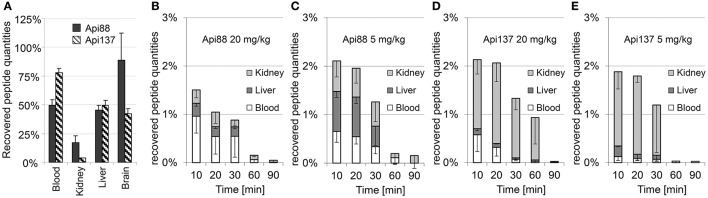
Mean recovery rates (n = 3) of Api88 and Api137 spiked to heparin blood or organ homogenates (A) and mean percentage rates recovered in blood, liver, and kidneys of mice treated intraperitoneal with doses of 20 mg/kg (B) and 5 mg/kg of Api88 (C) or 20 mg/kg (D) and 5 mg/kg of Api137 (E). Peptide distributions were calculated for plasma (one third of the whole mouse blood volume assumed to be 2.25 mL) and organs assuming that the peptides are present only in plasma and equally distributed in organ homogenates. Absolute quantities were calculated by assuming a total plasma volume of 25 mL/kg mouse weight and that organ volume in mL corresponds to the measured organ weight in g.